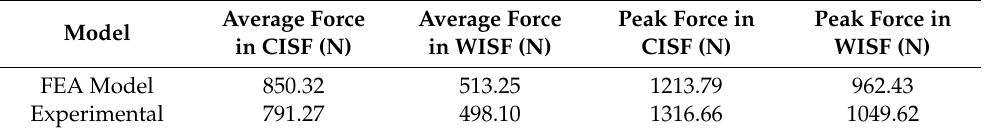
Table 6. Average and peak values of F x obtained from FEA model and experimentally. Model Average Force Average Force Model in CISF (N) in WISF (N)